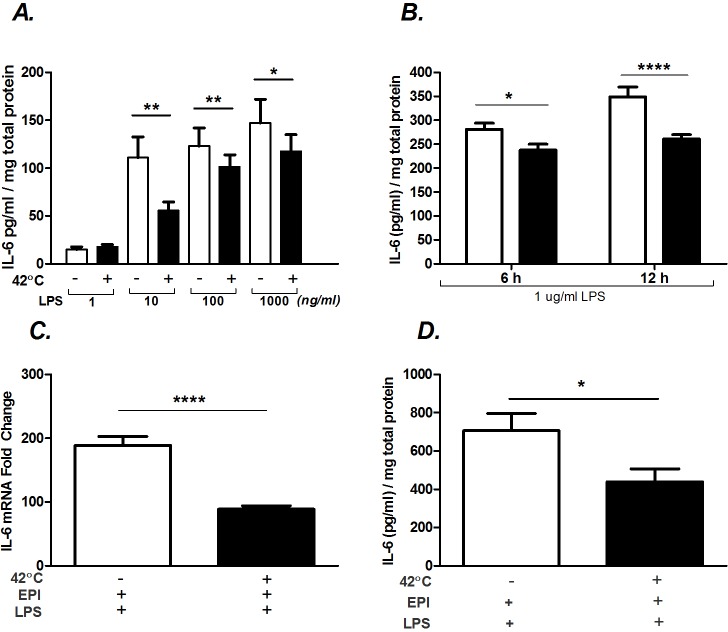
Hyperthermia attenuates LPS-induced IL-6 protein.A) Myotubes were treated with LPS (1–1000 ng/ml) and at 37°C 6 h or 42°C 1 h and 37°C 5 h. B) Myotubes were treated with LPS (1 μg/ml) and at 37°C 6 h or 42°C 1 h and 37°C 5 h. C and D) Myotubes were co-stimulated with LPS (1 μg/ml) plus EPI (100 ng/ml) and 37°C 6 h or 42°C 1 h and 37°C 5 h. Supernatants (A,B,D) were sampled for IL-6 protein analysis using ELISA. Values are expressed relative to the total protein content from cells in each well. C) IL-6 mRNA was evaluated by qRT-PCR. Results from multiple cultures, 4 independent experiments, 2 samples/experiment; ANOVA. * Comparison during matching experimental treatments 37 vs. 42°C; * (P<0.05), ** (P<0.01), and **** (P<0.0001).